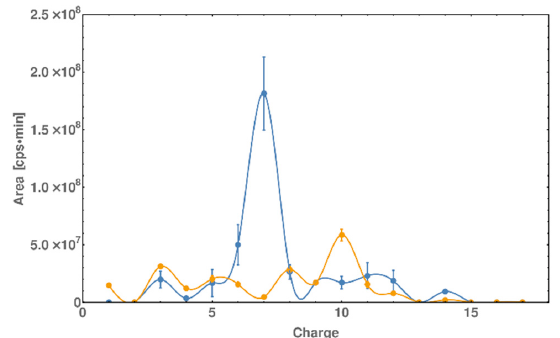
Figure 7. Digestion pattern of dsDNA (blue) and dsDNA*-PEP (orange) by DNase I [Charge axis correspond to the following sequence starting from 5’ end—ssDNA* A (5’-GCA CGT CAT CCG TATAG-3’)]. The resulting chromatogram (based on data similar to the PAGE method) is taken from LC-MS analysis. Each peak on TIC (total ion current) was identified and their areas were plotted against the charge of the recognized fragment. The AP-1 sequence corresponds to the 5 to 8 charge fragment. 200 pmol of dsDNA*-PEP or dsDNA was incubated with 0.04 U of DNase I in 10 mM CaCl 2 , 100 mM MgCl 2 , 100 mM Tris-HCl (pH 8.9) buffer solution. The digestion was performed at 4 °C for 10 min.